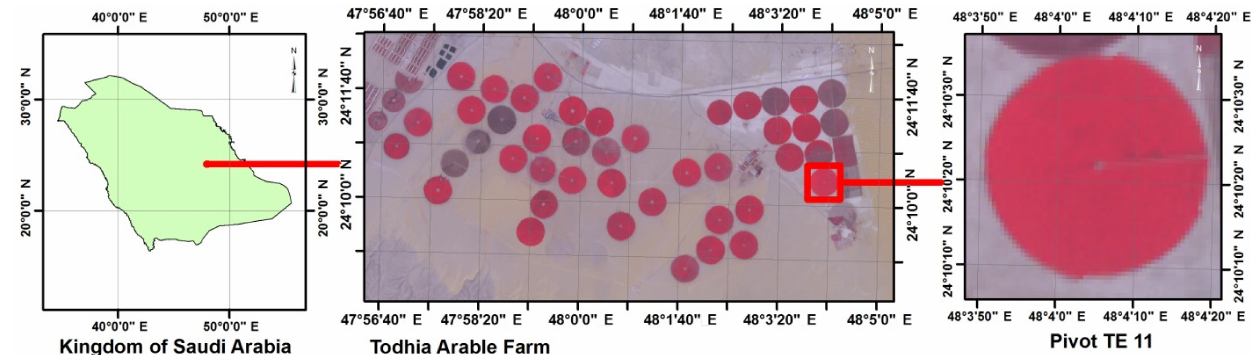
Figure 1. Location map of the study